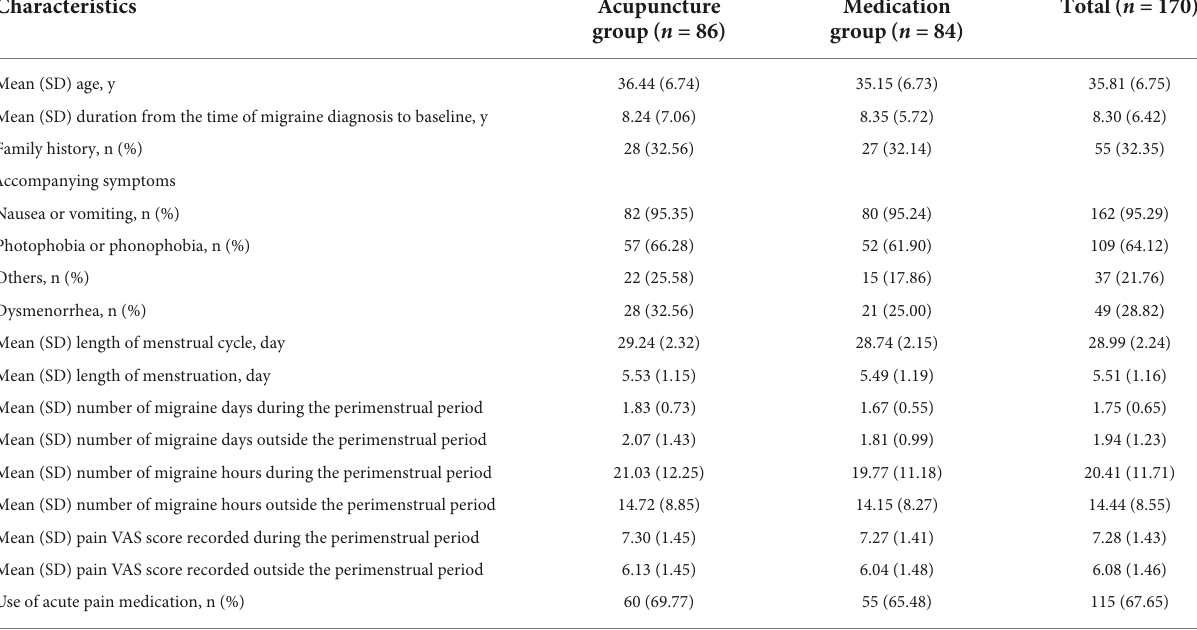
TABLE 1 Demographic and baseline characteristics of the 170 patients included in the intention-to-treat